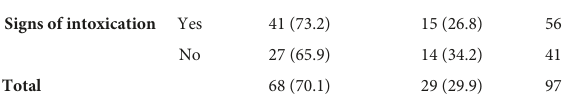
TABLE 6 Interrogation outcomes as a function of suspects’ intoxication status in Study 2 ( N = 97).